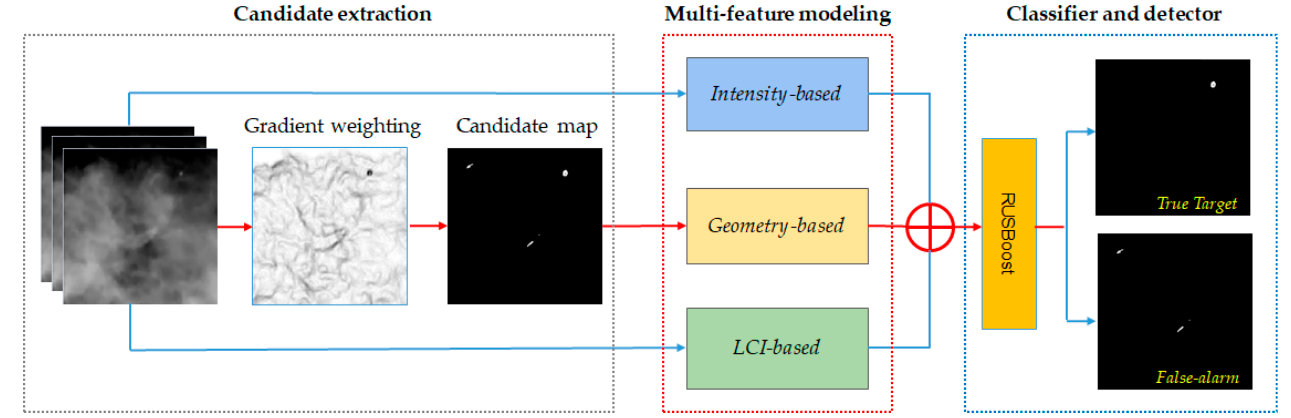
Figure 2. The overall framework of the proposed algorithm.